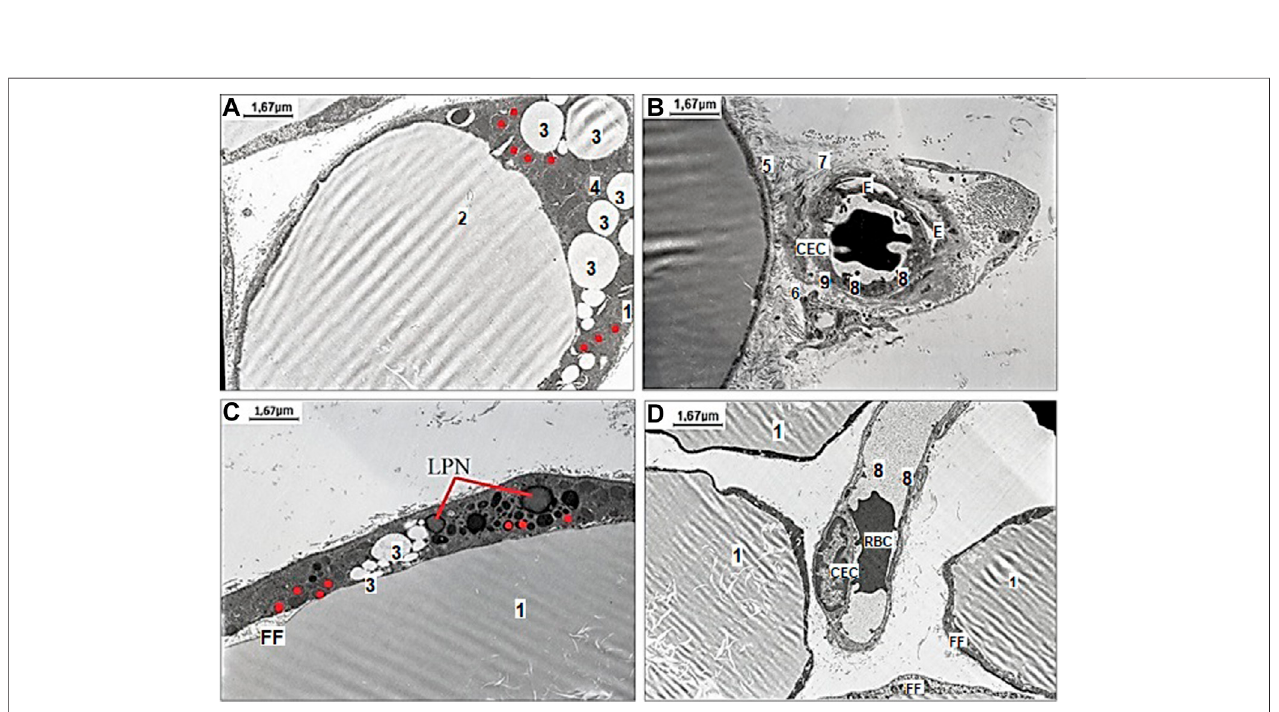
FIGURE 3 | Representative pictures of the effect of fructose-feeding and stress induction on ultrastructural examination of mesenteric material harvested from the area associated with the small intestine of aged rats with vehicle (A – B) and NaHS (C,D) treatment. (A) The degenerating adipocyte 1) with signs of fat fragmentation 2), withsmall lipiddrops3)inthecytoplasm4)ofadipocytesand differentshaped mitochondria (originalmagni fi cation × 6,000). (B) Evidenceofadipocytedamageincludes disrupted basal membrane 5), cell debris in the interstitium 6), disorganized collagen fi bers 7), and changes the microarchitecture of the capillary endothelial cells (CEC) with microvilli 8), destruction of basal membrane 9), and edema (E) around the capillary space with destructive red blood cell (RBC) in the lumen (original magni fi cation × 6,000). (C) The adipocyte with signs of fat fragmentation, smaller drops of fat in the cytoplasm of adipocytes, lipid-laden phagolysosomes (LPN) and detective ring-like mitochondria (original magni fi cation × 6,000). (D) Well preserved capillary endothelial cells with destructive erythrocyte (RBC) adhered to endotheliocytes in the lumen surrounded with few adipocytes without signs of fat fragmentation (FF) (original magni fi cation × 6,000). Red dots mark ring-like